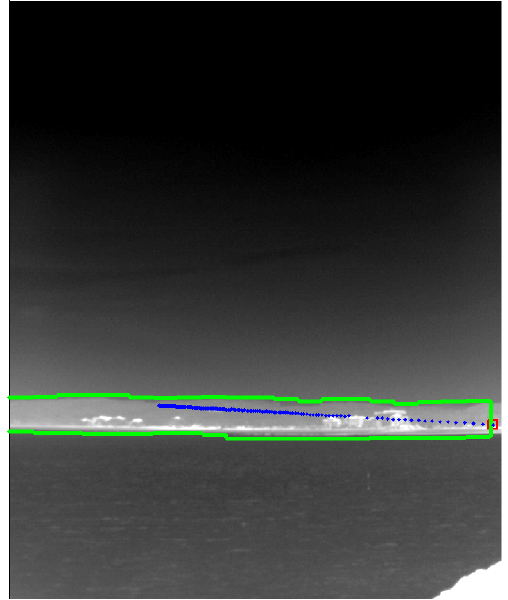
Figure 27. Final footprint of target detection using a temporal filter (TCF) in the identified coastal region. The blue dots represent the detected target